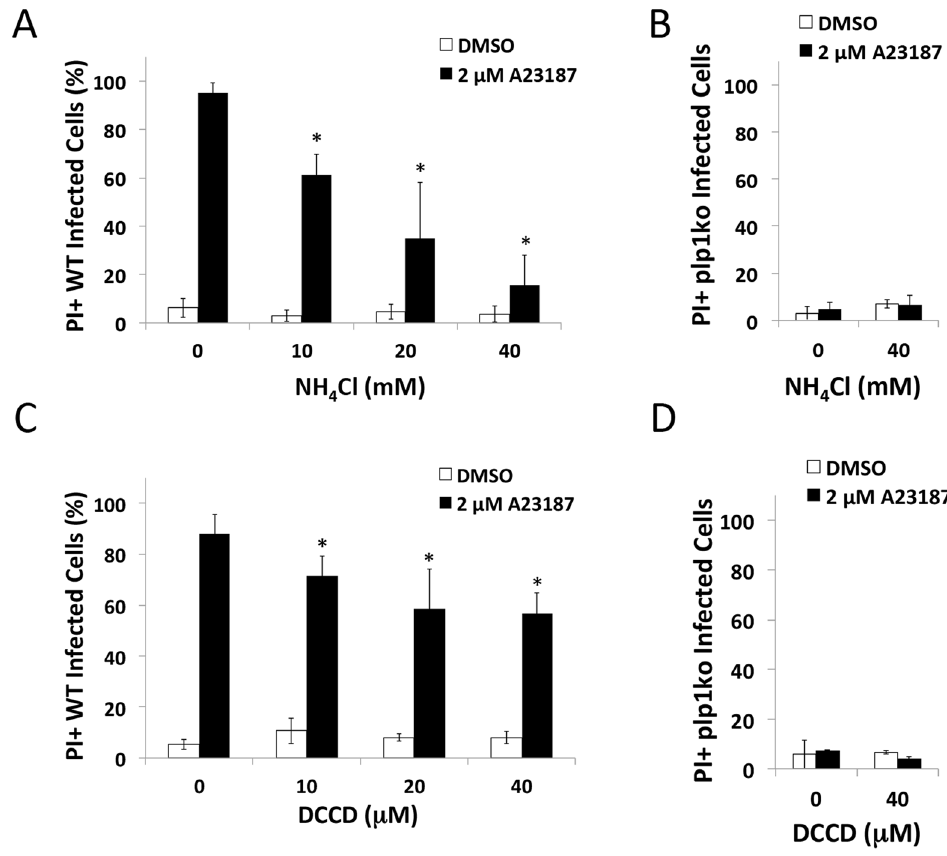
Figure 4. pH-neutralizing agents reduce egress-associated membrane permeabilization. (A–D) RH (WT) or plp1ko infected cells were incubated for 30 h prior to treatment with 1 m M CytD with or without inhibitor for 3 min followed by 1 m M CytD with vehicle (DMSO) or ionophore (2 m M A23187) with or without inhibitor plus 12.5 m g/ml propidium iodide (PI) for 3 min. Cells were fixed and stained with DAPI. Infected cells were determined by brightfield and PI positivity by nuclei fluorescent in the red channel. Results indicate average and standard deviation of 3 independent experiments for WT and 2 independent experiments for plp1ko . * p , 0.05 by student’s t -test.